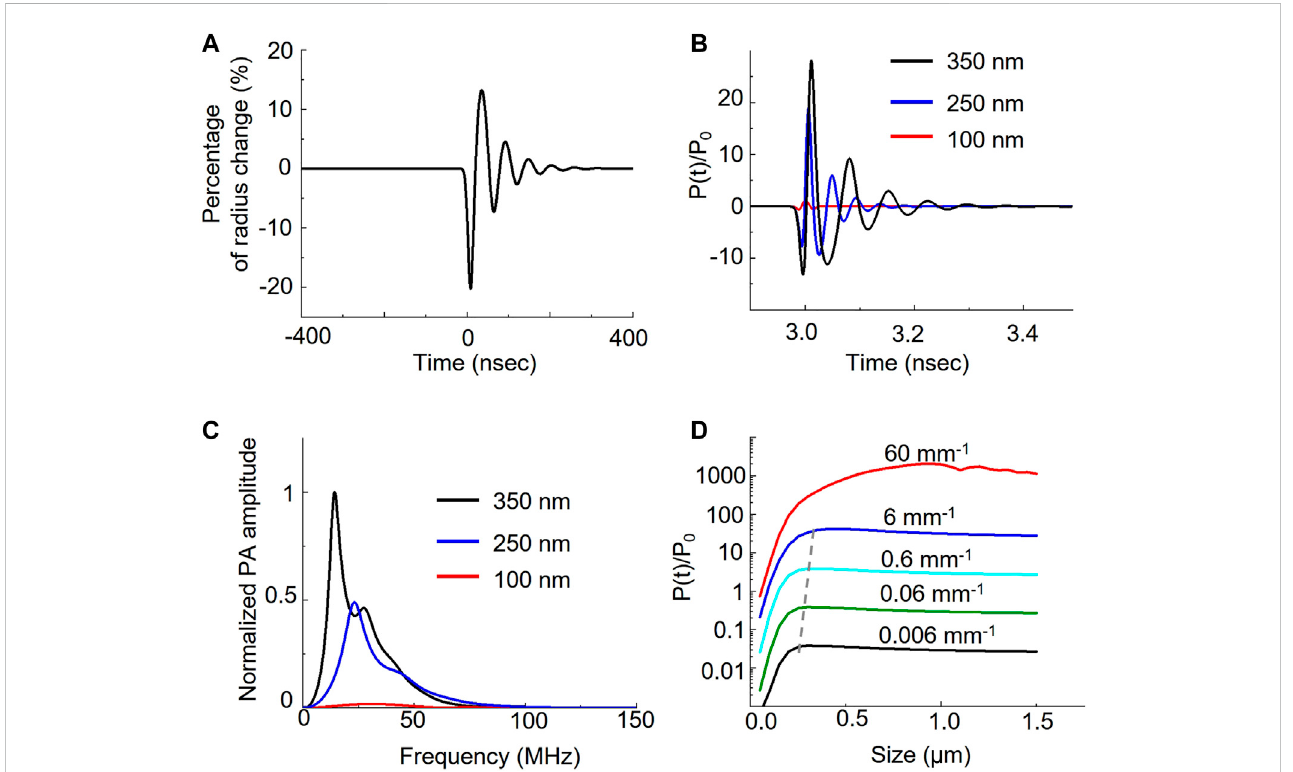
FIGURE 3 Theoretical analysis of nanobubble induced photoacoustic enhancement. Laser irradiation induces photoacoustic pressure on the ICG shell of the nanobubble.Thepressurefurtherinducestheoscillationofnanobubble. (A) Thebubbleradiusoscillatesovertimewheninteractingwithphotoacousticsignal of ICG dyes. (B) Different bubble size results in the different pressure distribution. The photoacoustic pressure, P(t), is normalized to ambient pressure, P 0 . (C) Frequency response ofthephotoacoustic pressure in different sizes. (D) Comparison ofthe photoacoustic pressureas afunction ofnanobubble sizes in various optical absorption of